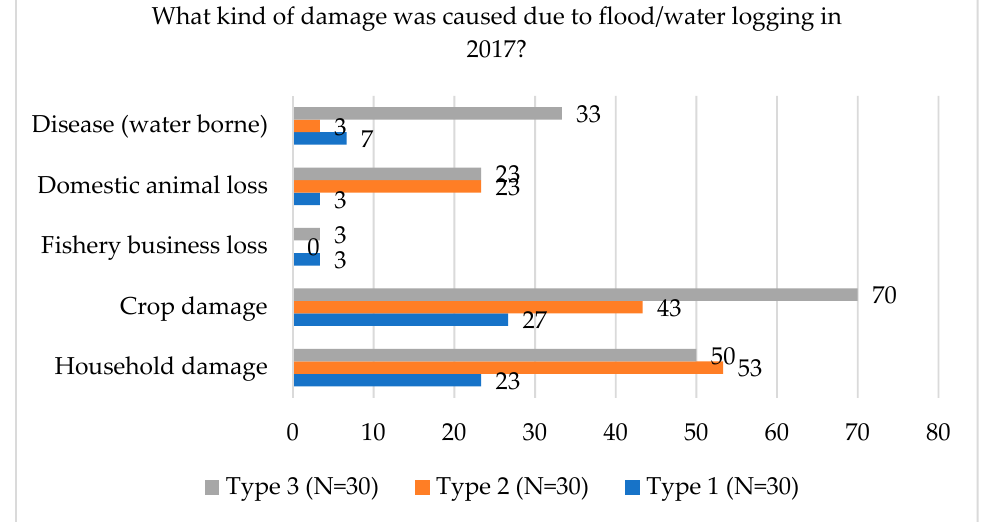
Figure 3. Type of damages caused by the flood/waterlogging due to embankment breach in 2017, as reported by the respondents (%) in questionnaire survey.